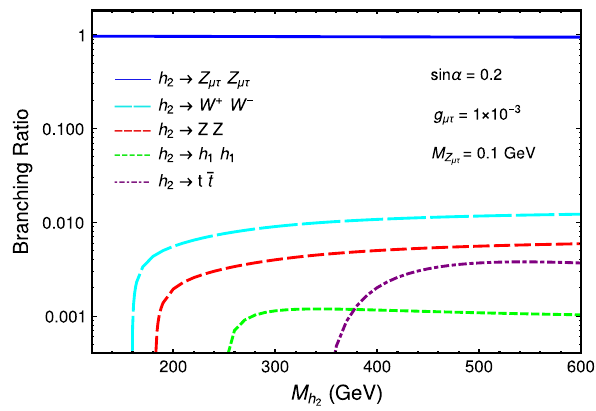
Fig. 1 The branching ratios for the main decay modes of the scalar h 2 as functions of M h for the fixed values sin α = 0 . 2, M Z μτ = 0 . 1 GeV 2 and g μτ = 1 × 10 −